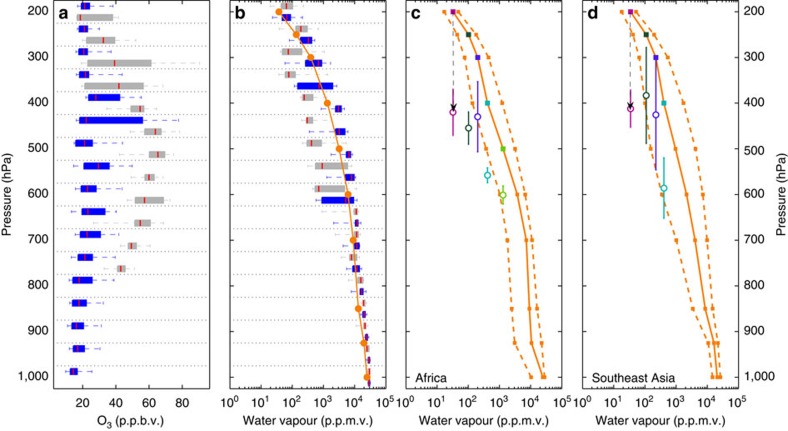
Structure of ozone and water vapour in the TWP.(a) Profiles of in situ O3 during CAST and CONTRAST for two modes of RH (blue, RH >20%; grey, RH <20%). Box and whisker plots show 5th, 25th, 50th, 75th and 95th percentiles for 50 hPa pressure bins. Each bin is delimited by a dotted line, and the two modes (grey and blue boxes) for a given pressure bin are offset for clarity. Between 400 and 700 hPa, the average (minimum) number of observations per blue and grey box is 650 (414) and 330 (43), respectively. Observations between 300 and 400 hPa were more limited with a minimum of 20 and a maximum of 56 observations. (b) Distribution of H2O for two modes of HCN (grey, HCN >150 p.p.t.v.; blue, HCN <150 p.p.t.v.). Median AIRS H2O over the ascending branch of the Hadley Cell (orange). Between 300 and 700 hPa, the average (minimum) number of observations per blue and grey box is 129 (28) and 111 (19), respectively. (c) Median (solid), 5th and 95th percentiles (dashed) of AIRS H2O over the African biomass burning region (orange). Open circles represent the mean end point of descent ±1σ of trajectories starting over the African biomass burning region and arriving over the TWP, for various initial pressures (closed squares). d Same as c but for trajectories starting over Southeast Asia.